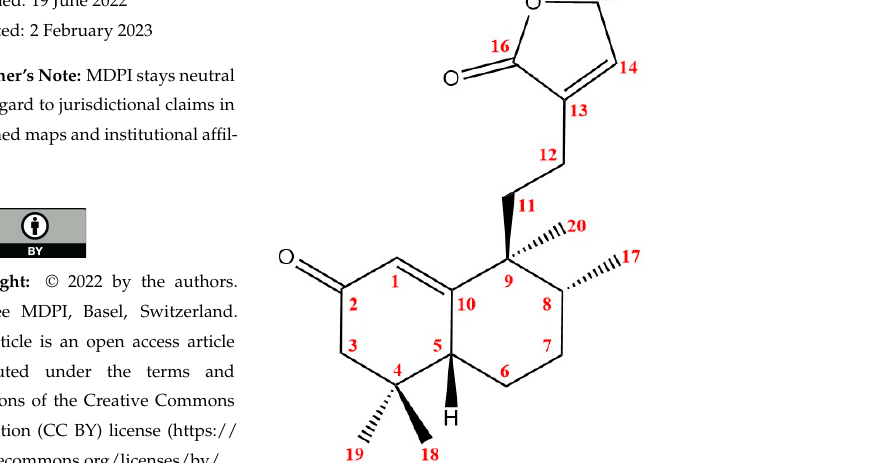
Figure 1. Structure of compound 1 .